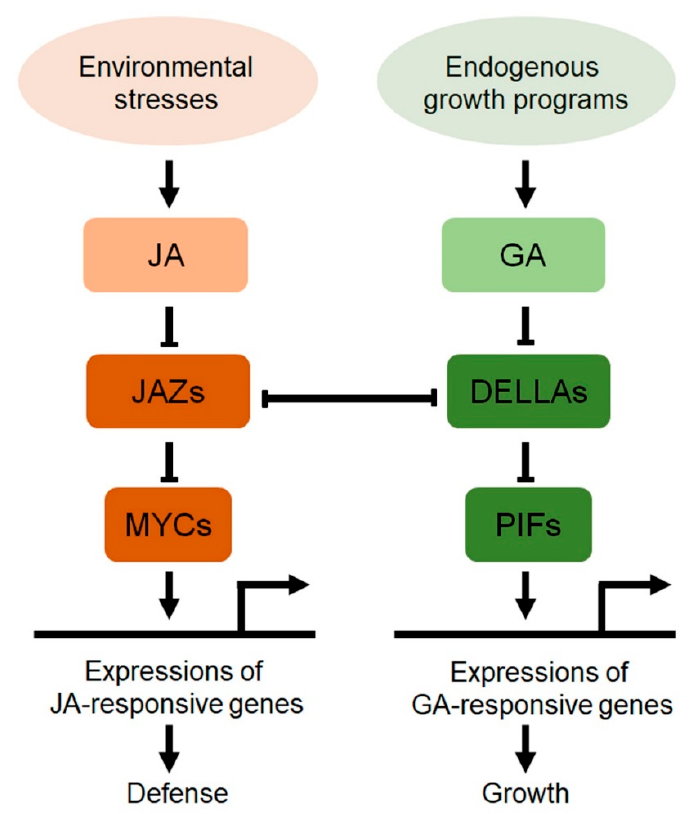
Figure 1. A schematic of crosstalk between jasmonic acid (JA) and gibberellic acid (GA) in coordination between plant growth and defense. JA and GA antagonistically interact to coordinate plant growth and defense, and the crosstalk is mediated by direct interaction between JA signaling repressors, JASMONATE ZIM-DOMAIN (JAZs), and GA signaling repressors, DELLAs. MYCs and PHYTOCHROME INTERACTING FACTORS (PIFs) indicates transcription factors responsible for transcription of JA-responsive and GA-responsive genes, respectively. The arrows and T bars indicate positive and negative regulation, respectively.